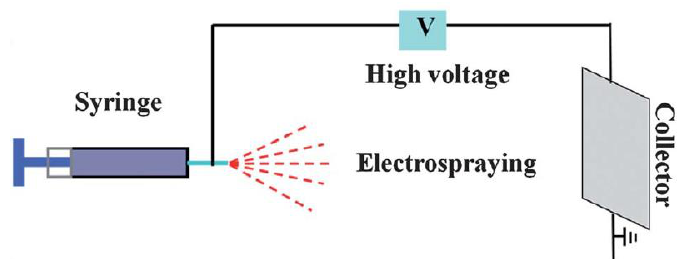
Figure 6. Schematic illustration of the electrospraying process. Reproduced from [71] with permission of The Royal Society of Chemistry, 2014.